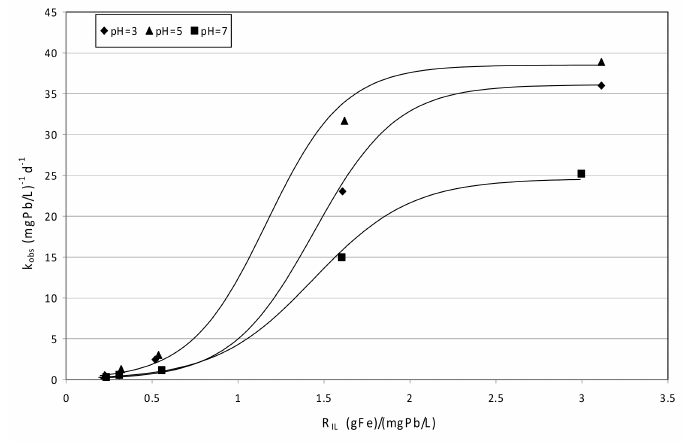
Figure 19. Observed kinetic constant (k obs ), detected during the tests with mZVI, vs. Fe/C i